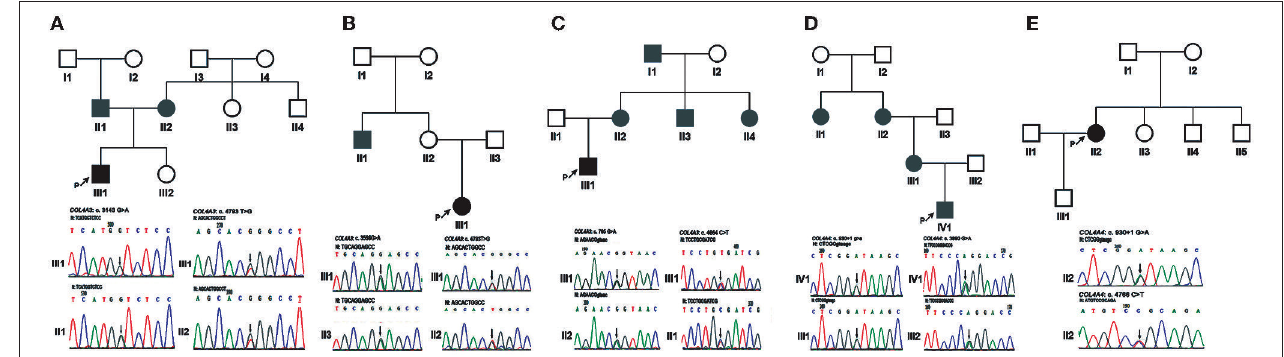
FIGURE 1 | The pedigree of five families and Sanger sequencing of PCR amplified products containing the variants for probands 1–5 and their parents. (A) Family 1. (B) Family 2. (C) Family 3. (D) Family 4. (E) Family 5. Black arrows indicate the probands and the changed nucleotides. The filled black squares and circles indicate the individuals who presented with haematuria and proteinuria, and the filled grey squares and circles indicate the individuals who featured only haematuria. N, normal sequence. Intron and exon sequences are depicted by lower and capital case letters, respectively. The reference sequence of COL4A3 and COL4A4 transcripts was NM_000091.5 and NM_000092.5,